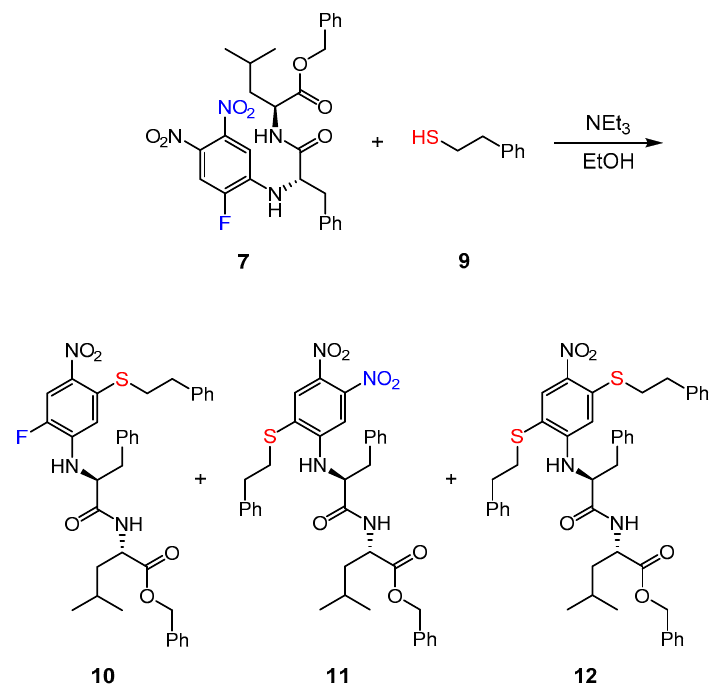
Table 2. Stabilities (only thiolate / thiolate and imidazolium: full optimization / thiolate and imidazolium: R(S-CX) fixed at 1.9 Å) of the Meisenheimer complexes in a polar solvent [in kcal / mol]. For all calculations the 6-31 + G* basis sets were employed. For further information see main text and Figure